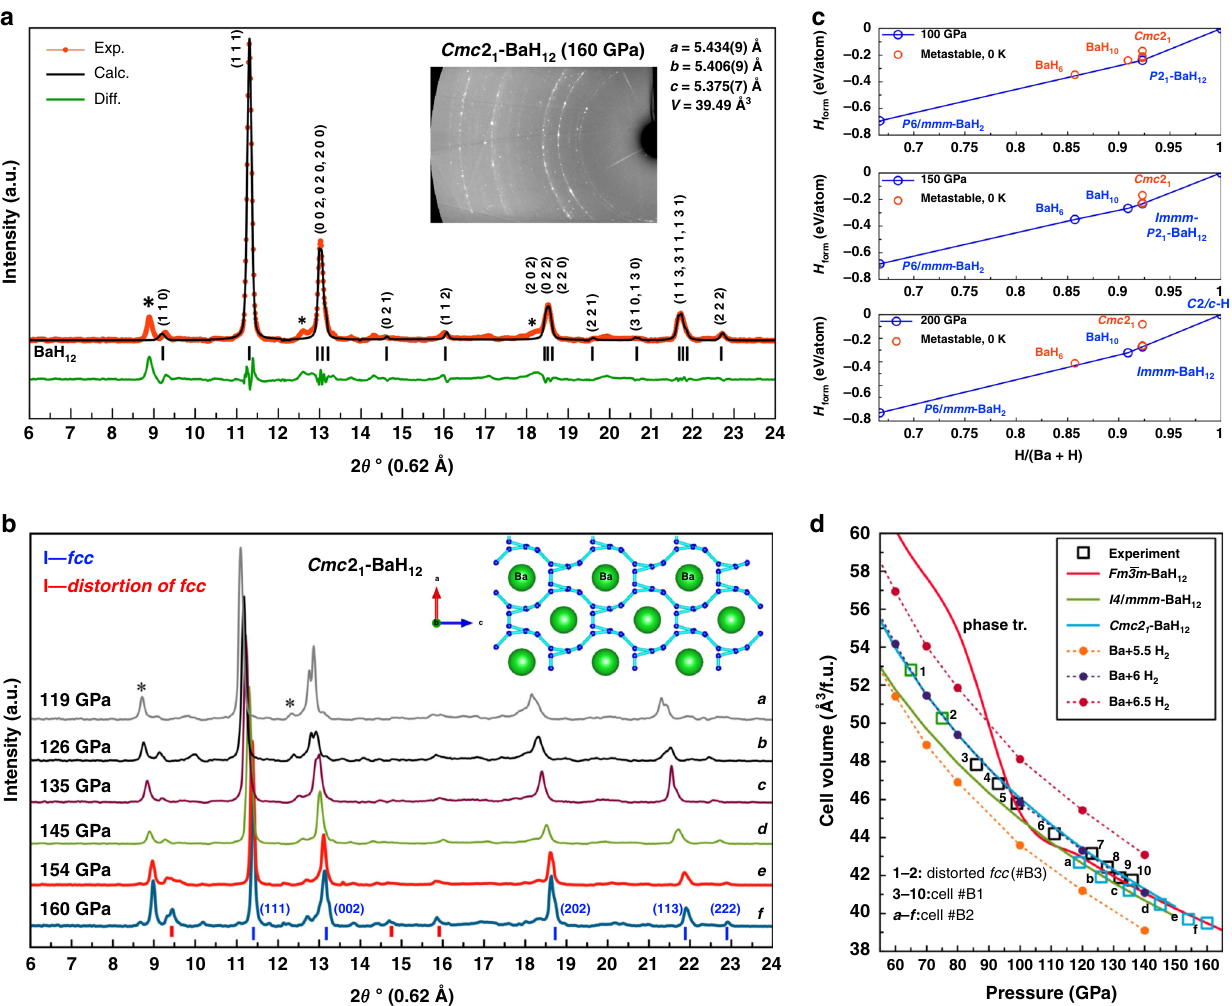
Fig. 1 XRD patterns of synthesized samples at various pressures with theoretical analysis of their stability. a Experimental X-ray diffraction pattern from DAC #B1 at 160 GPa and the Le Bail re fi nement of the pseudocubic Cmc 2 1 -BaH 12 phase. The experimental data, fi tted line, and residues are shown in red, black, and green, respectively. Unidenti fi ed re fl ections are indicated by asterisks. b X-ray diffraction patterns at pressures of 119 to 160 GPa. The inset shows the projection of the Cmc 2 1 structure to the ( ac ) plane. The hydrogen network is shown by light blue lines. c Convex hulls of the Ba – H system at 100, 150, and 200 GPa calculated with zero-point energy (ZPE) contribution. d Calculated equations of state for different possible crystal modi fi cations of BaH 12 ( fcc , I 4 /mmm , and Cmc 2 1 ) and Ba + n H 2 . The experimental data are shown by hollow However, all structures retrieved by molecular dynamics are less stable both dynamically and thermodynamically than P 1-BaH 12 , P 2 1 -BaH 12 , and Cmc 2 1 -BaH 12 found by USPEX. More accurate analysis accounting for the anharmonic nature of hydrogen oscillations 27 , which is actually beyond the scope of this work, may help to explain the experimental stability of higher- symmetry BaH 12 modi fi cations compared to lower-symmetry P 1-BaH 12 .